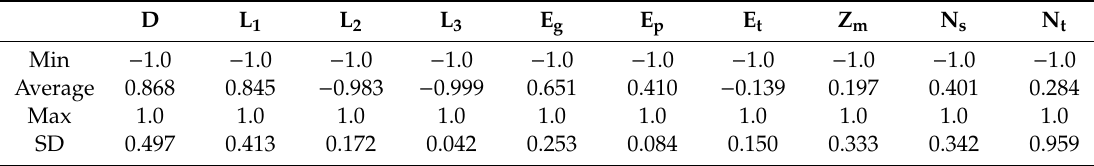
Table 2. Statistical values of the normalization process of the training dataset